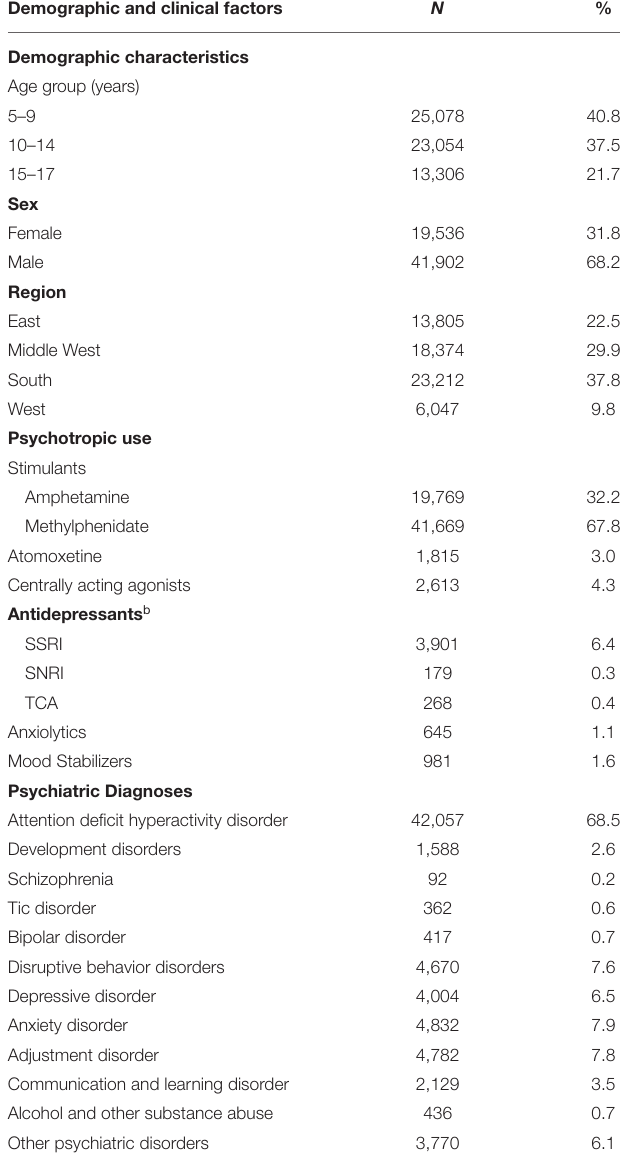
TABLE 1 | Baseline characteristics of commercially insured youth who initiated stimulants, 2006–2015 a ( N = 61,438). Demographic and clinical